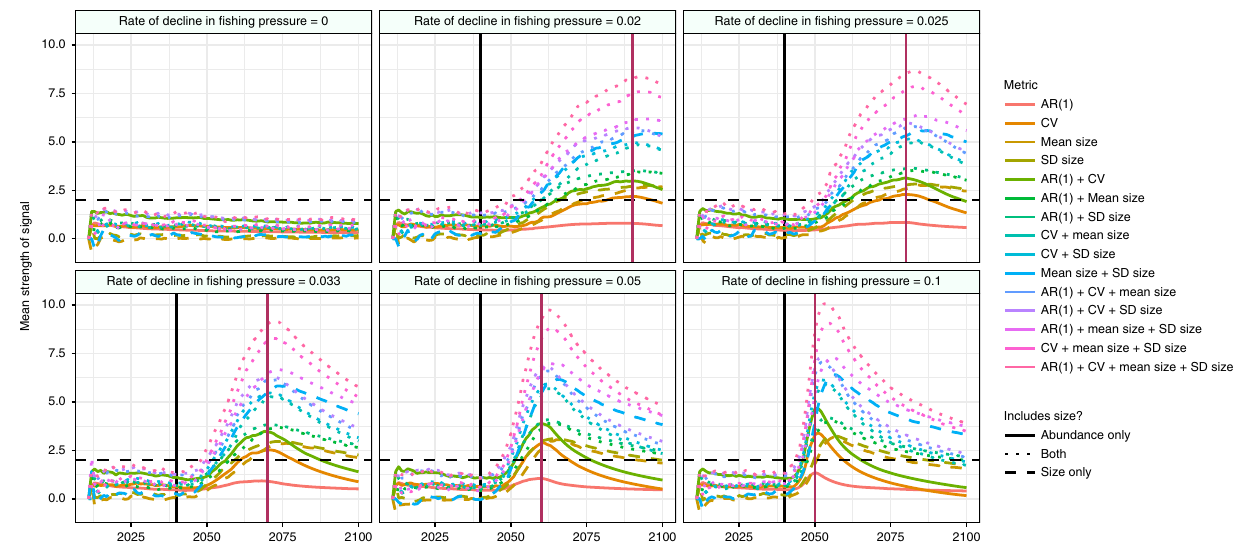
Fig. 3 Mean trends in the strength of EWSR compromised of trait and abundance signals across 300 simulations of each rate of decline in fi shing pressure. Those metrics that include size and abundance-based measures of stability (dotted lines) had signi fi cantly stronger signals of recovery than those based on either size (dashed lines) or abundance (solid lines) alone. Horizontal black lines indicate a 2 σ threshold where a warning signal is considered as present under the method proposed by Drake & Griffen 14 . Vertical black lines indicate the point in time where fi shing pressures begin to decline, vertical red lines show the point at which fi shing pressures had fallen to 0